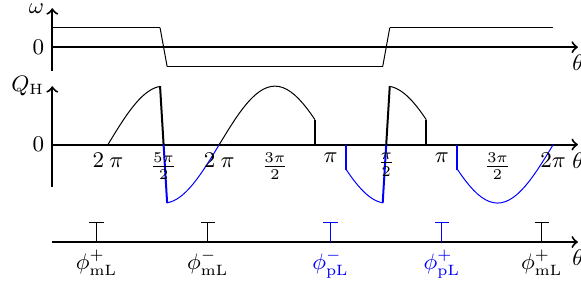
Figure 5: Illustration of response and sampling scheme with motion in both